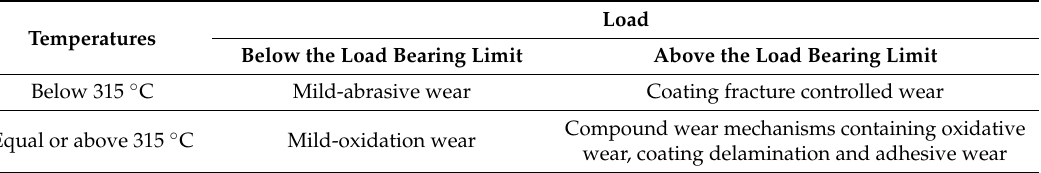
Table 6. Wear transition for CrN coated M50 steel at elevated temperatures and its